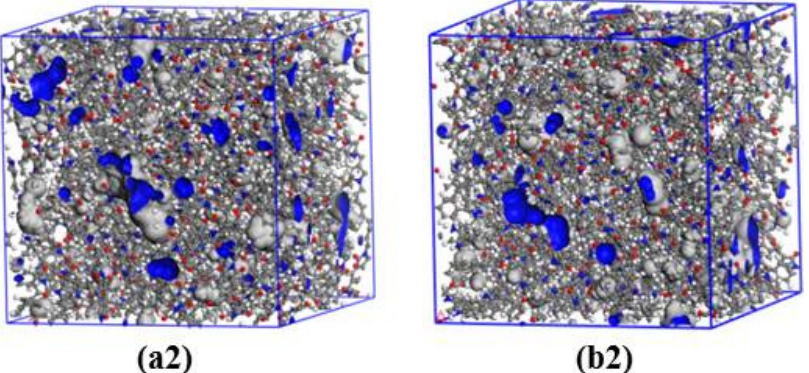
Figure 9. Three-dimensional representation of H 2 O and O 2 accessible volume for ( a1 , a2 ) M-2,7-CPPI and ( b1 , b2 ) 2,7-CPPI. (grey: Van der Waals surface; blue: Connolly surface; ( a1 , b1 ): probe radius of 1.325 Å; ( a2 , b2 ): probe radius of 1.73 Å).